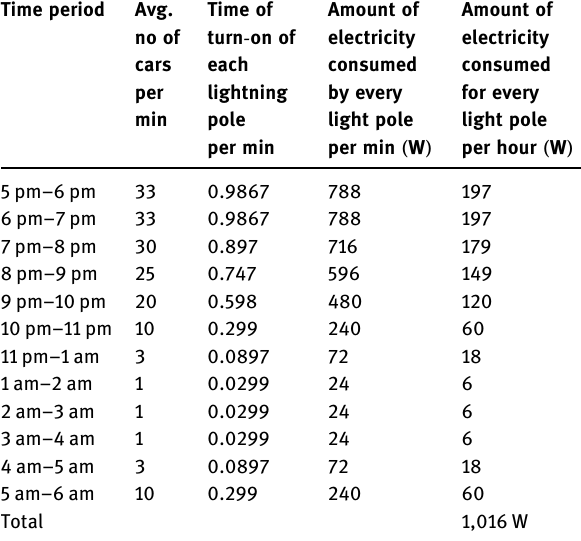
Table 2: Total amount of the energy consumed by each lighting pole in every 1 hour during the lighting time and the total amount of energy consumption for full time lighting for all the 1,800 poles by using CLS lighting system and HID lighting